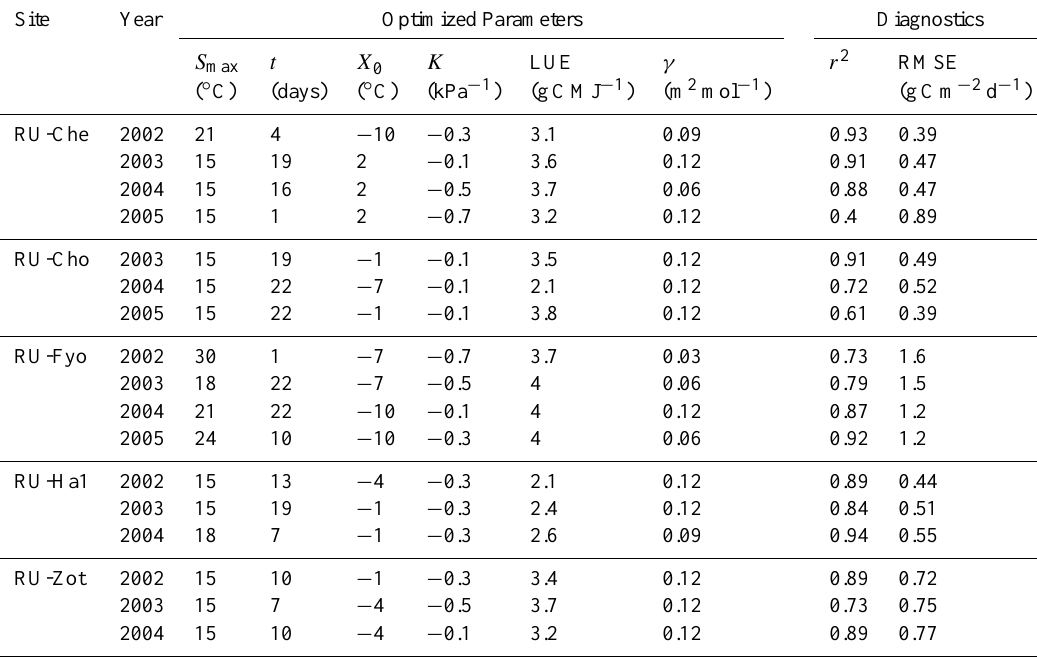
Table 5. Resulting optimized model parameters and regression diagnostics for the LUE-TAL model by site and year.